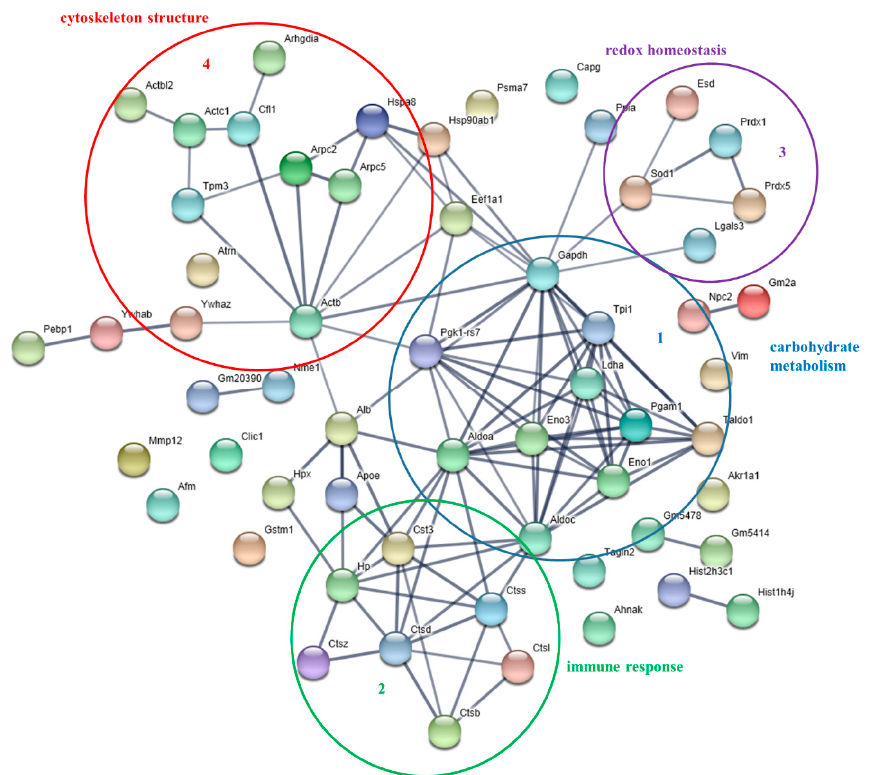
Figure 2. Protein–protein interaction network of proteins identified in the secretome of immature DCs. The Gene Name according to UniProtKB are reported. The network was obtained using the EMBL STRING with a confidence cut-off of 0.700 [24]. The four main functional modules are circled and numbered.